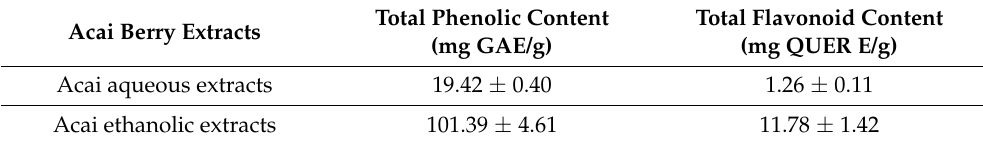
Table 2. Total phenolic (TPC) and flavonoid (TFC) contents of acai berry aqueous and ethanolic extracts.